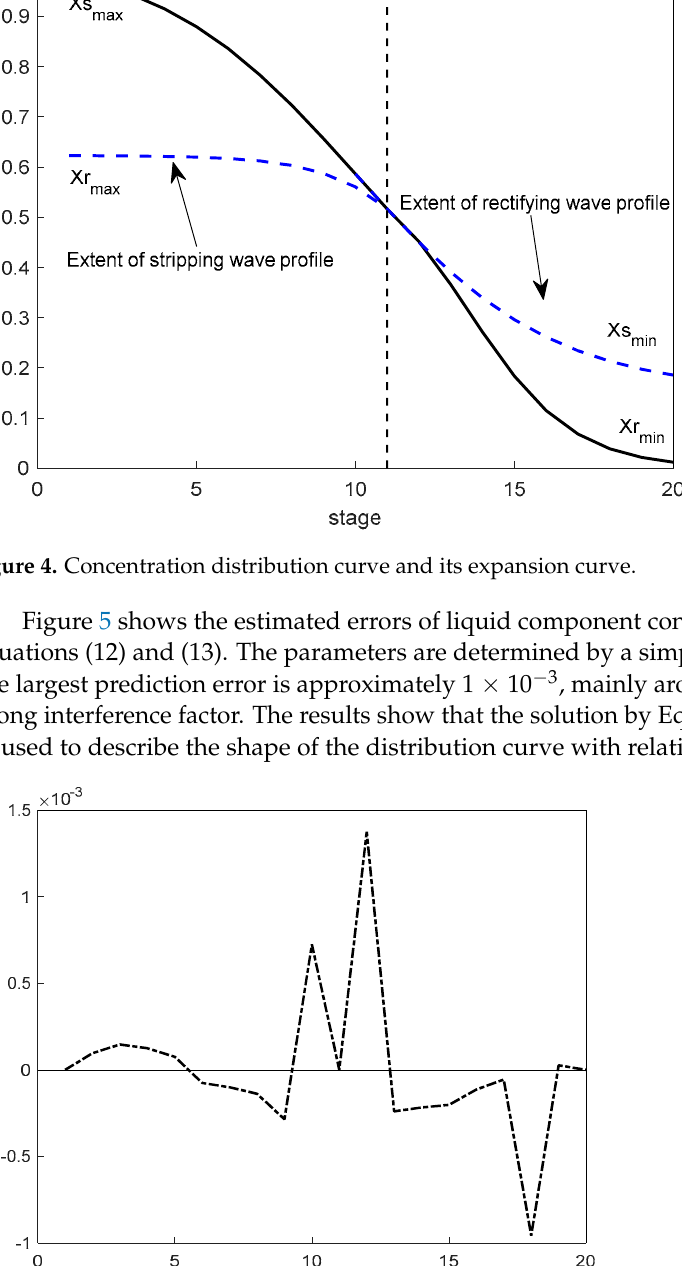
Figure 5. The observed error of the function described by the concentration distribution.